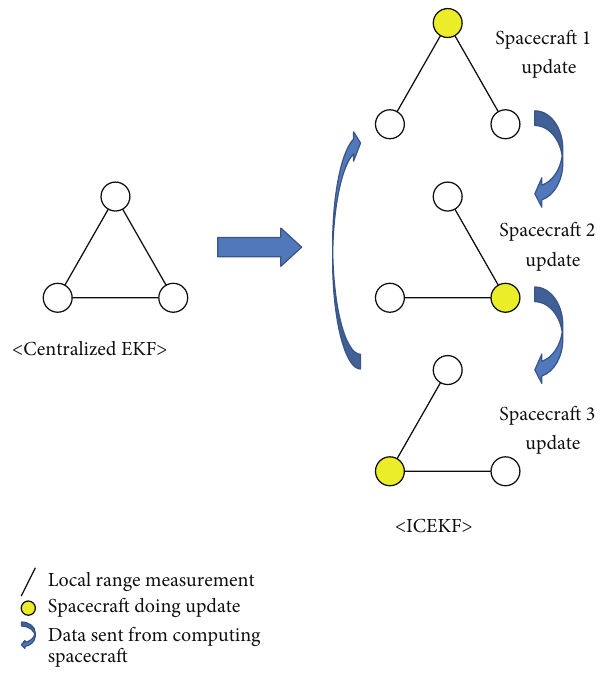
Figure 1: ICEKF compared with centralized EKF